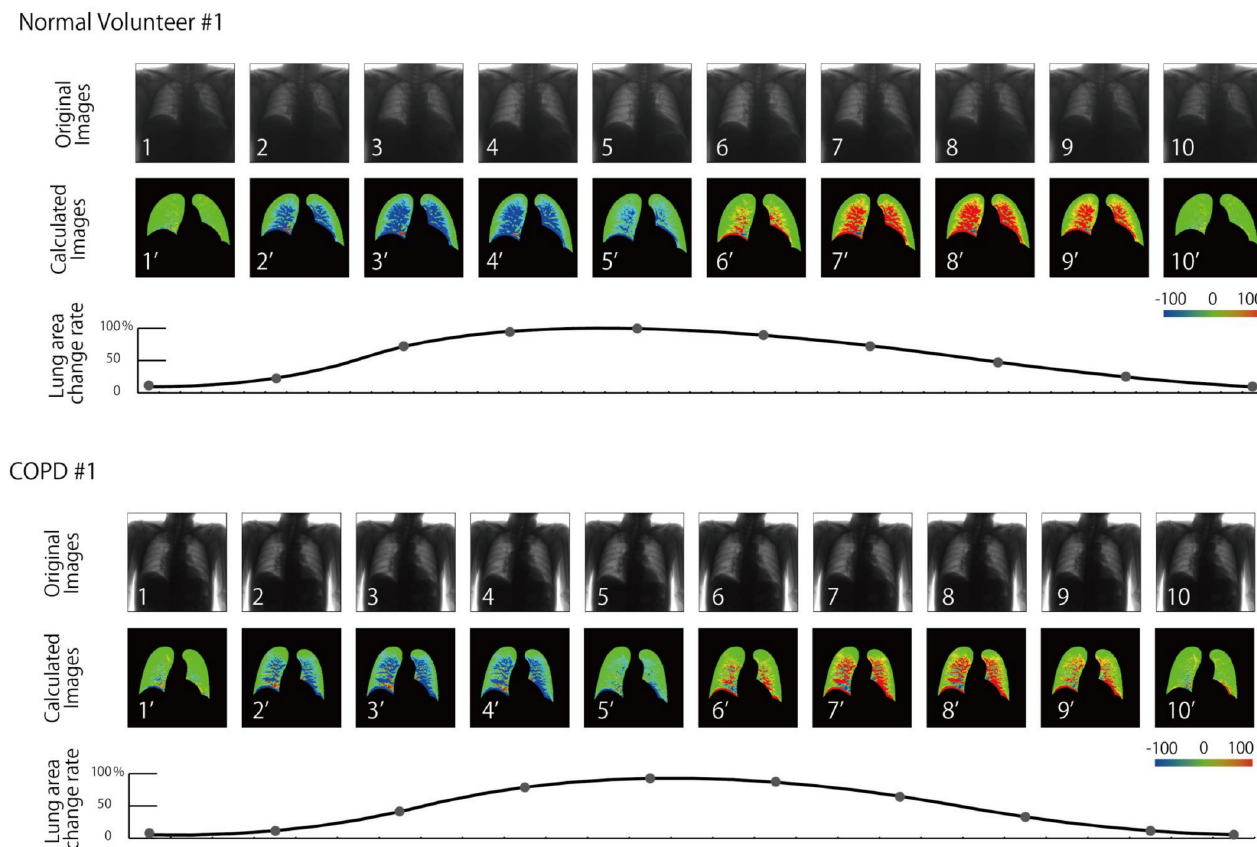
Fig 5. Generated dynamic images of a normal volunteer (#1) and patient with COPD